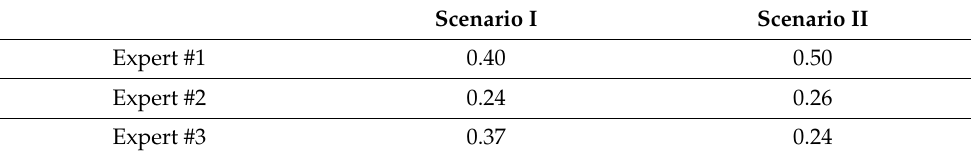
Table 7. Experts’ authority levels.